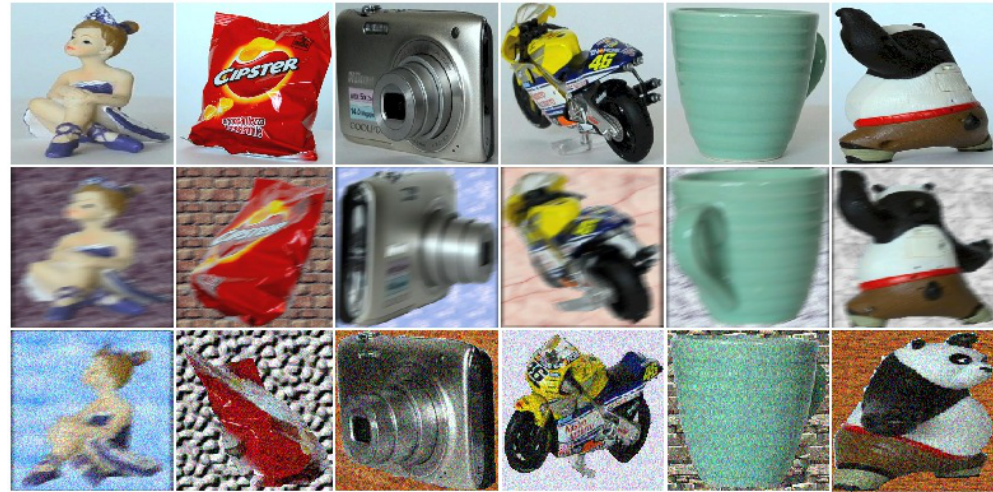
Figure 4. Test image examples from SMO without noise ( first line), with motion blur ( second line), and with additive Gaussian noise ( third line). Various textured backgrounds were added.